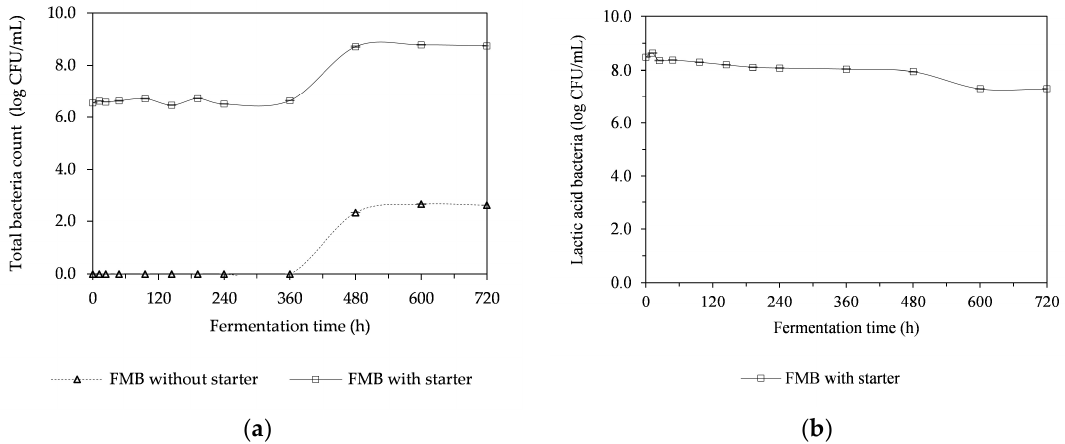
Figure 8. The change of microbial load in a fermented mushroom beverage (FMB) with and without starter culture L. plantarum SK15 during fermentation time: ( a ) total bacteria count; ( b ) lactic acid bacteria (LAB).